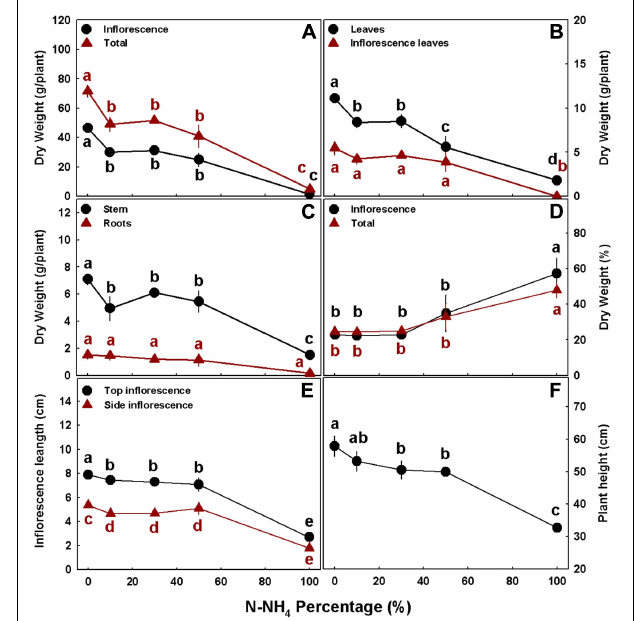
FIGURE 3 | Effect of NH 4 /NO 3 ratio on plant biomass and development in medical cannabis plants. Dry weights of inflorescences and whole plant (A) , leaves and inflorescence leaves (B) , stem and roots (C) , % dry weight of inflorescences and whole plant (D) , inflorescence length for the top (primary) inflorescence and side (secondary) inflorescence (E) , and plant height (F) . Presented data are averages ± SE ( n = 5). Different small letters above the means represent significant differences between treatments within a curve by Tukey HSD test at α =